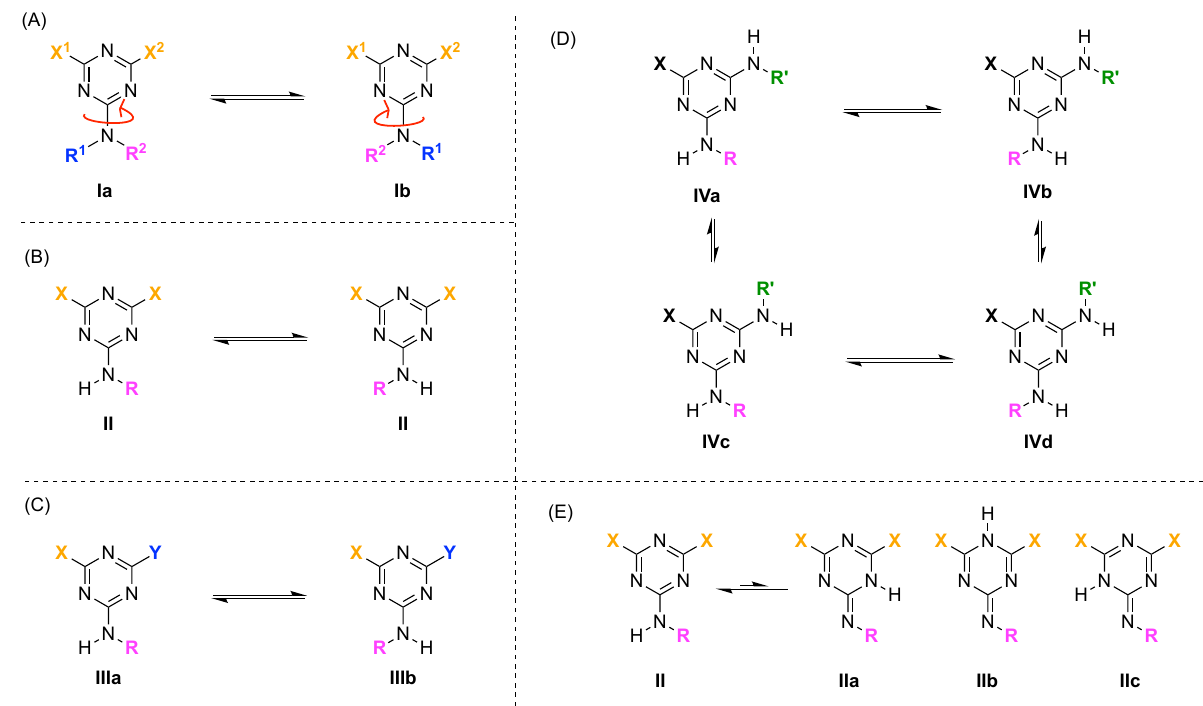
Figure 34. Conformational interconversion due to hindered C–N bond rotation in substituted aminotriazines. ( A ) Rotamers Ia and Ib ; ( B ) the two structures shown are identical ( II ) yet the two X groups have distinct environments, which may be manifest in the NMR spectrum; and ( C ) Rotamers IIIa and IIIb ; ( D ) four rotamers of IV ; ( E ) tautomers IIa–c of II .